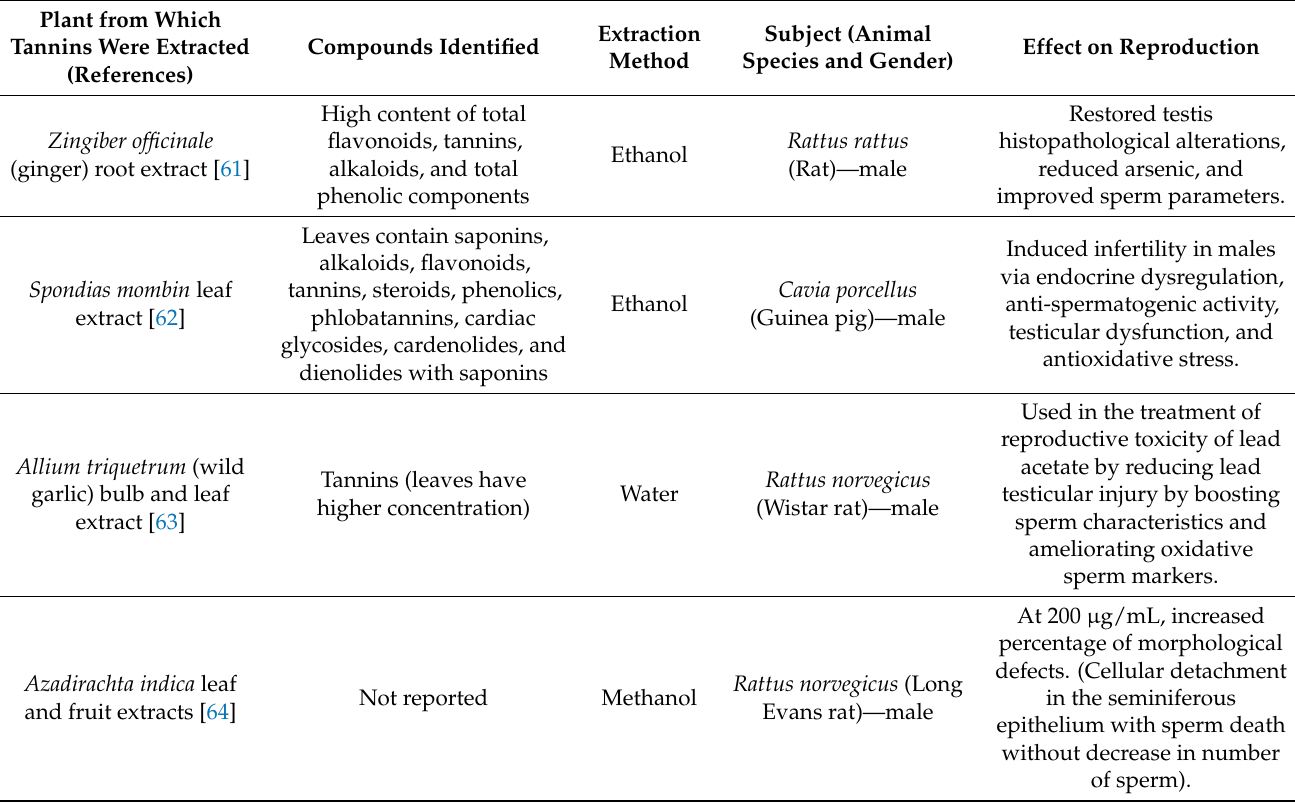
Table 1. Reported effects of tannin extracts used as food/feed supplements on reproduction outcomes in humans or